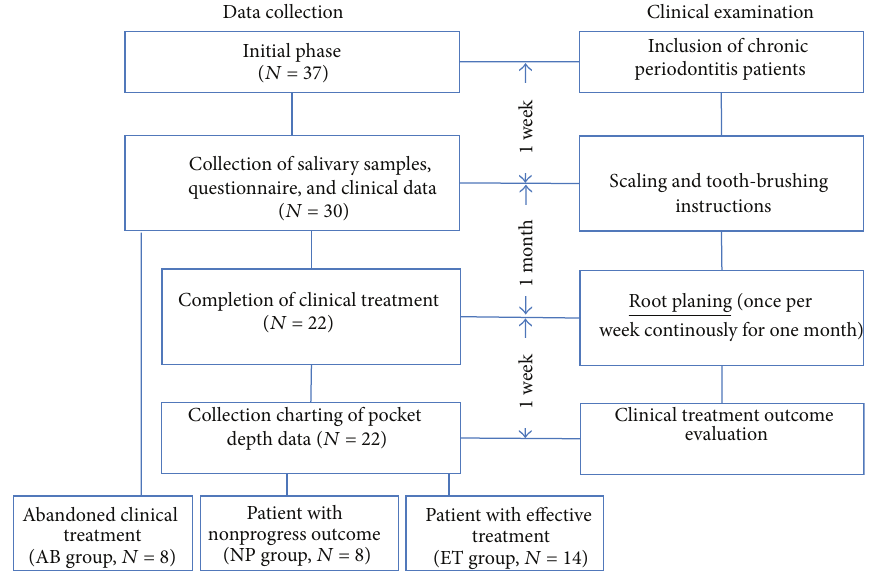
Figure 1: Data collection and clinical examination protocol